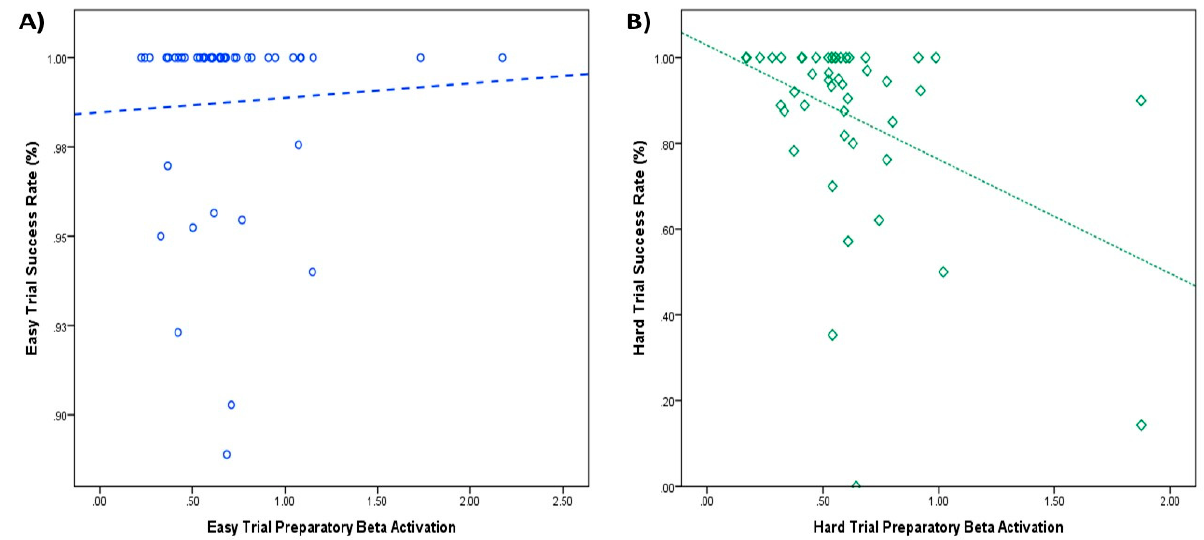
Figure 2. Preparatory beta activation and trial success rates. ( A ) Easy trial preparatory beta activation does not predict easy trial success rates ( blue ). ( B ) Hard trial preparatory beta activation predicts hard trial success rates ( green ). Lower beta activation scores represent greater cortical motor-action preparation. Higher trial success rates represent better per- formance.